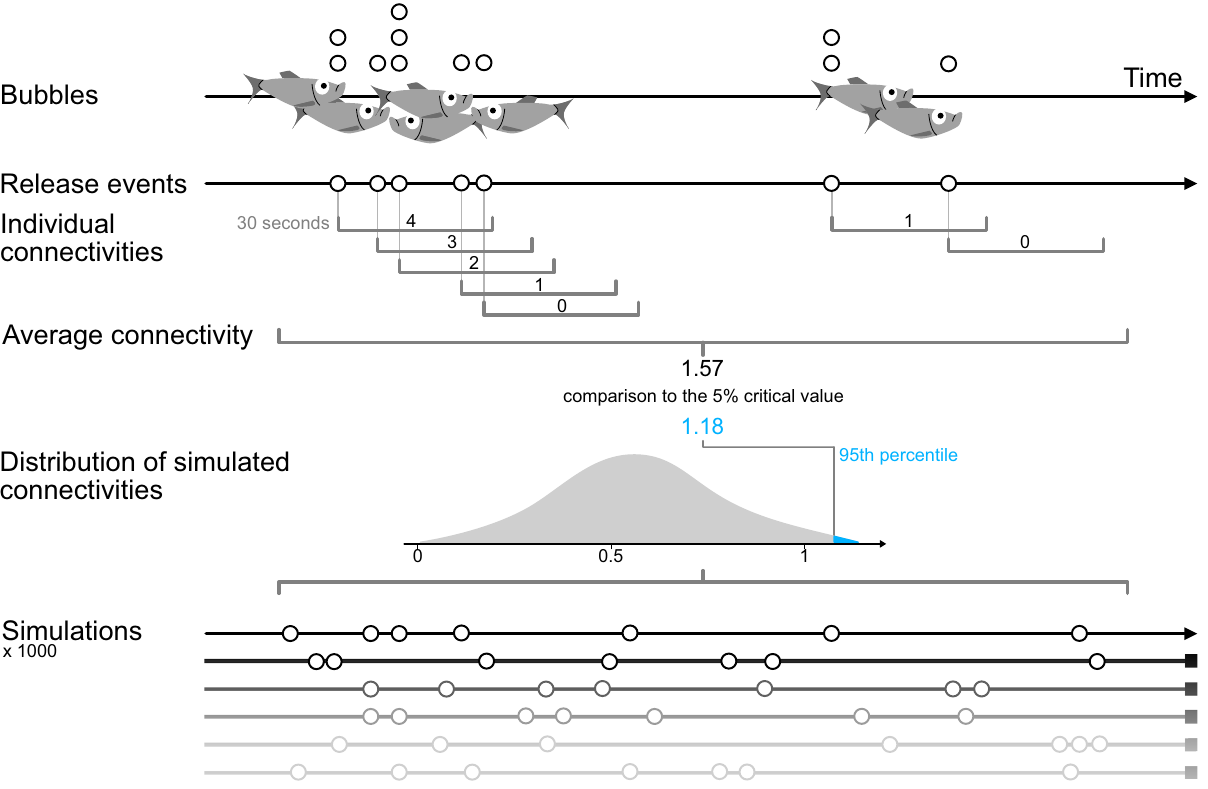
Figure 5. Illustration of the steps related to the simulated connectivity test (S-CON test). Bubbles occurring within 10 s are pooled into single release events. We then determine the connectivity of each release event— aka the number of release events within the following 30 s time window. From these, we calculate the average connectivity for a specified period (1, 5, 30 min, 1-, 2-, 4- and 6-h intervals). In a final step, we compare the observed average connectivity to the critical value which is defined as the 95th percentile of 1000 simulations of random placements of the same number of releases. If the observed connectivity is larger than the critical value, we reject the null hypothesis of random gas releases for the specified time